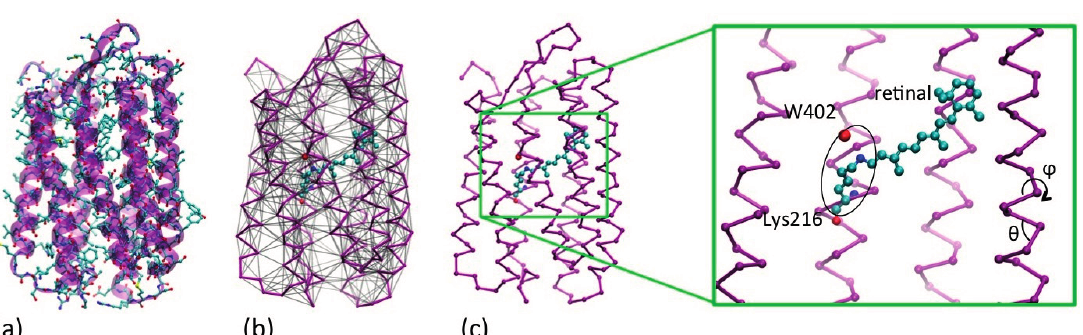
Figure 2. ( a ) Quasi-atomistic representation of the BR superimposed to cartoon representation ( b ) UA/CG representation of the protein: opsin minimalist model in purple and the retinal and water402 in quasi atomistic representation, colored by name (C = cyan, N = blue, O = red). The network of non-bonded interactions is represented in grey ( c ) The same as (b), without the non-bonded interactions for clarity, and with an expaned view of the active site. The retinal, the Schiff base linkage with Lys216 and the water are highlighted, as far as the internal conformational variables of the CG opsin model ( θ , ϕ